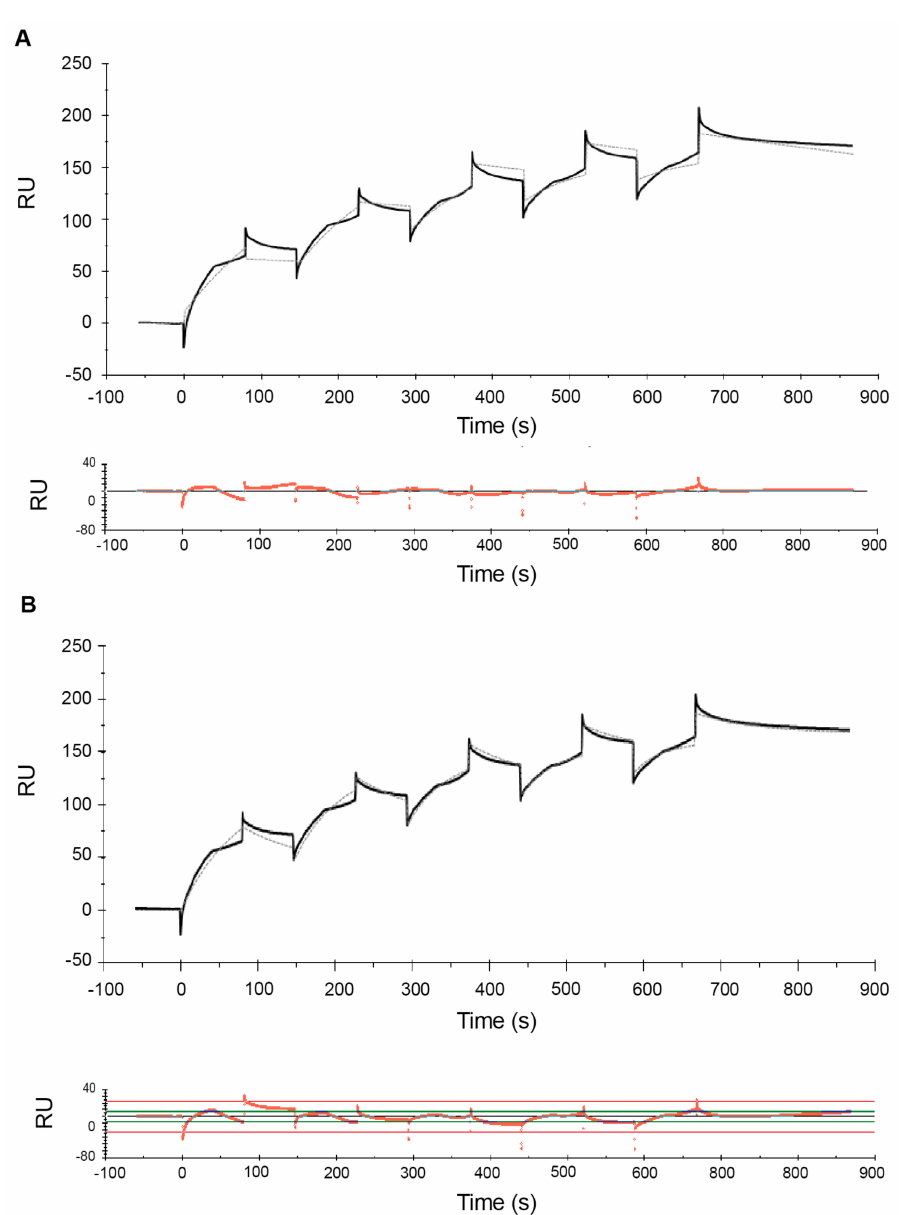
Figure 3. Sensorgrams of the melittin–POPC interaction using single-cycle kinetics for the low-range concentrations. Following immobilization of POPC liposomes (1 mM lipid) to a binding response of ~3500 RU, increasing concentrations of melittin (0.04, 0.06, 0.08, 0.1 and 0.12 µ M) were serially injected in a single-cycle at a flow rate of 30 µ L / min for 80 s with a single regeneration step with 10 mM glycine–HCl (pH 2.5) at the end, i.e., after all five concentrations of melittin. Binding kinetics analysis of the sensorgrams using a Langmuir 1:1 model ( A ) and a two-state reaction model ( B ) were conducted using BIAevaluation ® software. The estimated rate constants and a ffi nity values, based on both these models, are listed in Tables 1 and